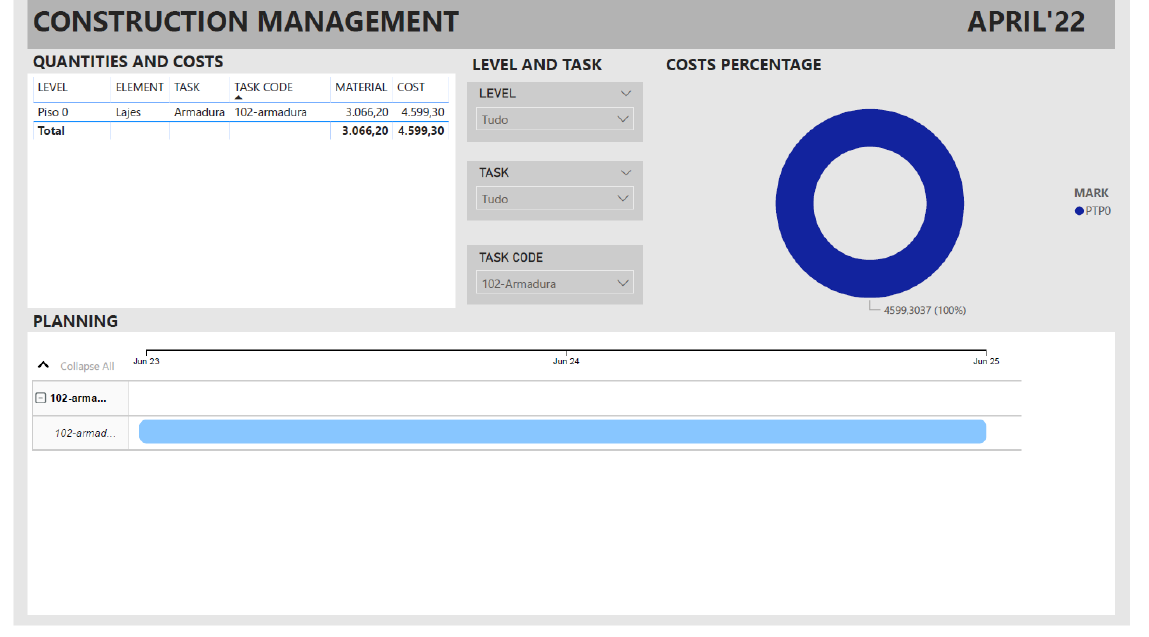
Figure 11. Power BI dashboards—by task